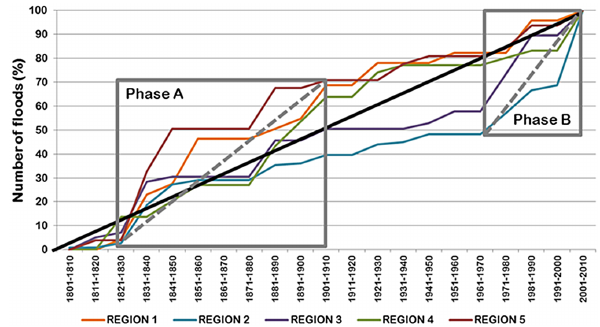
Figure 8. Cumulative number of floods (in %) versus time, for each region: the cumulative frequencies are obtained by adding the abso- lute frequencies of all years up to the year referred to. Black line: Bisector of the quadrant where the distribution of the floods is per-